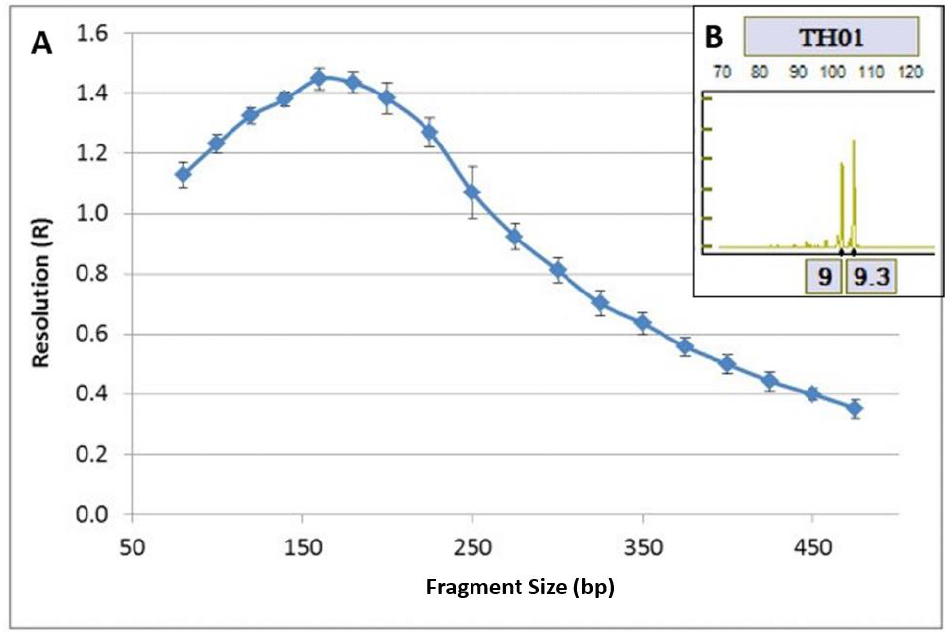
Figure 4. ( A ) Resolution calculated from internal lane standard (ILS) of 104 samples, ( B ) Microvariant detection example—3 bp microvariant at TH01.